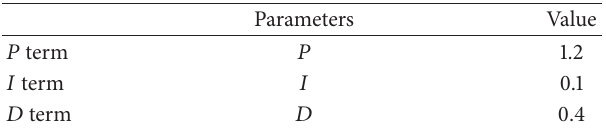
Table 2: Control parameter